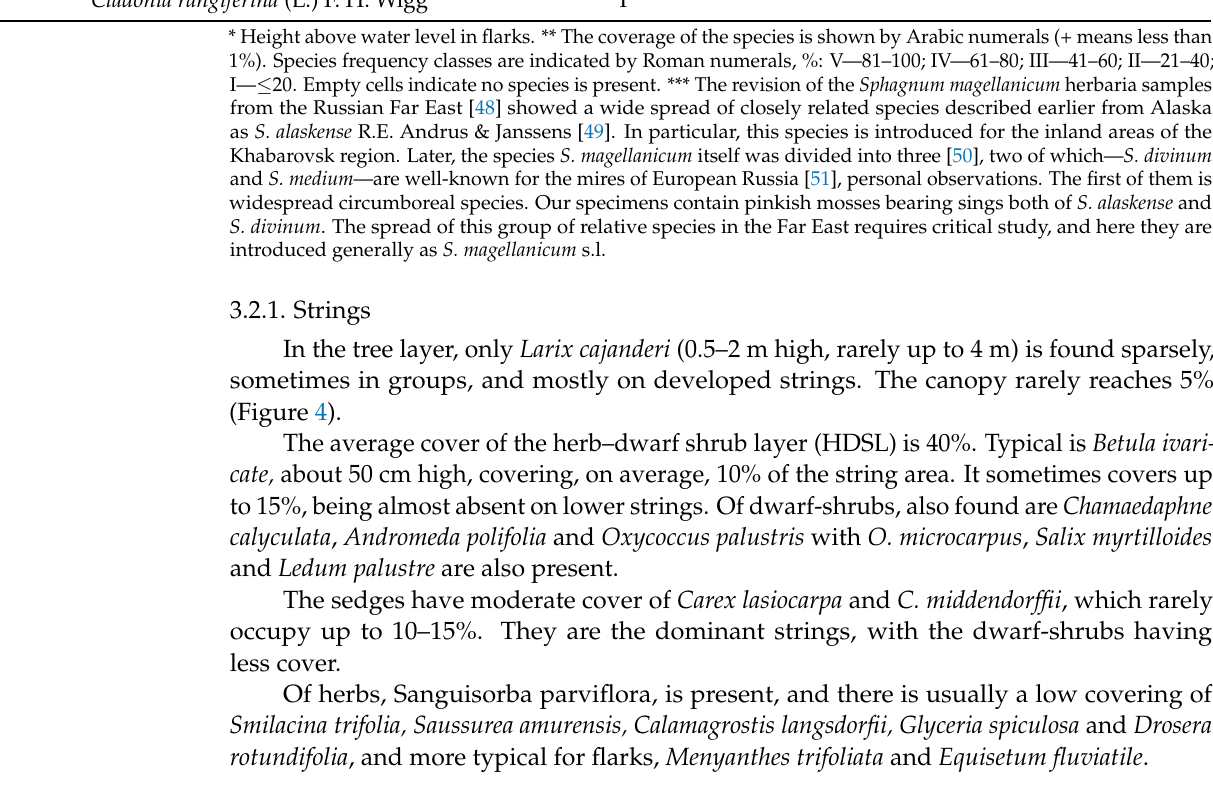
String, Height * of 25–50 cm